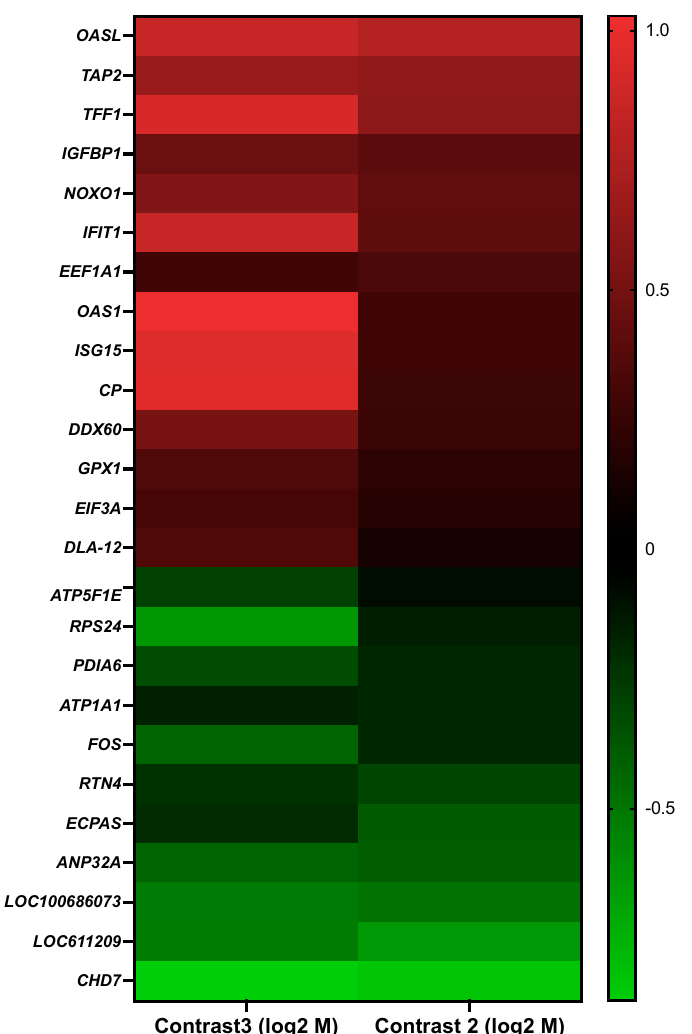
Figure 9. A heat map representing the color-coded expression levels (log-ratio M values) of 25 DEGs exhibiting a similar pattern of expression between the IBD enteroids and colonoids following LPS stimulation. The log-ratio M values represent the log(R/G) (log fold change) [44]. The detailed information on genes is presented in Table 11. Table 11. The Gene Ontology (GO) analysis and details about the DEGs exhibiting a similar pattern of expression between the IBD enteroids and colonoids following LPS stimulation annotated for the biological process, molecular function, and cellular component categories. The number of genes that fell into each of these categories is shown in percentages.